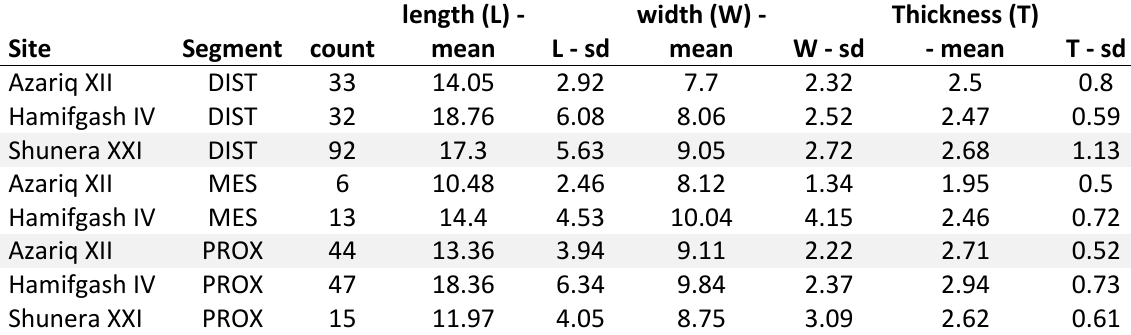
Table 12. Main dimensions of